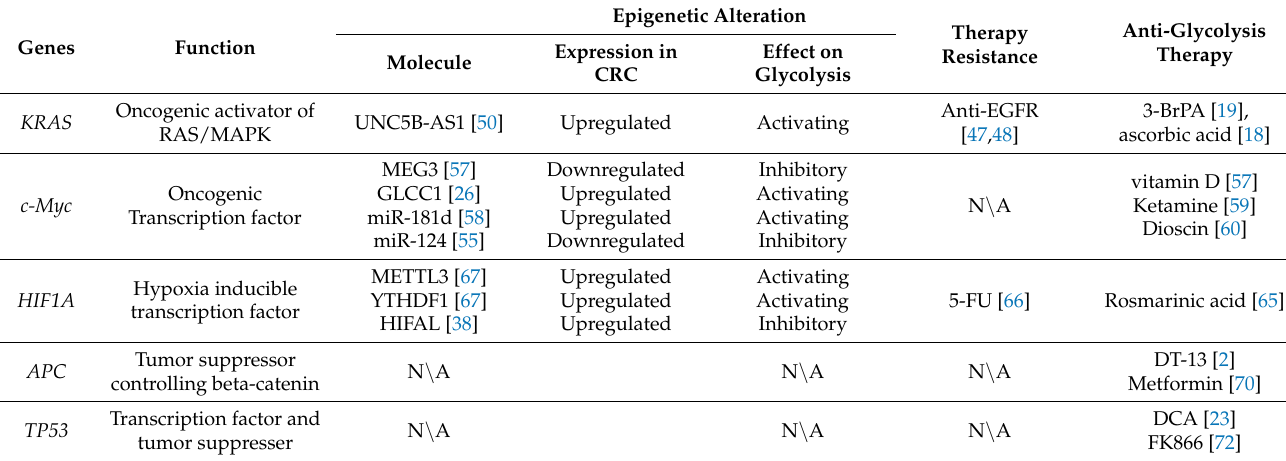
Table 1. Warburg effect-mediating molecules and their associated epigenetic alteration, resistance to chemotherapy, and tested anti-glycolytic drugs for